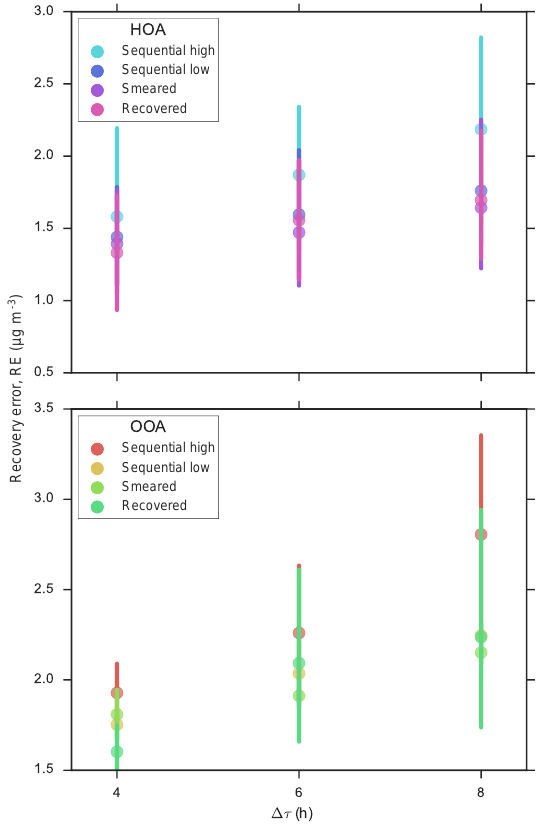
Figure 12. Mean recovery error (RE) against sample-collection time for HOA and OOA time series processed by the sequential, smeared and recovered methods. T = 57h and κ m = 20%. The “sequential high” and “sequential low” time series are constructed by linear interpolation between suboptimally and optimally sched- uled sequential measurements, respectively. The recovered solu- tions were obtained with TSVD regularization and the truncated boundary